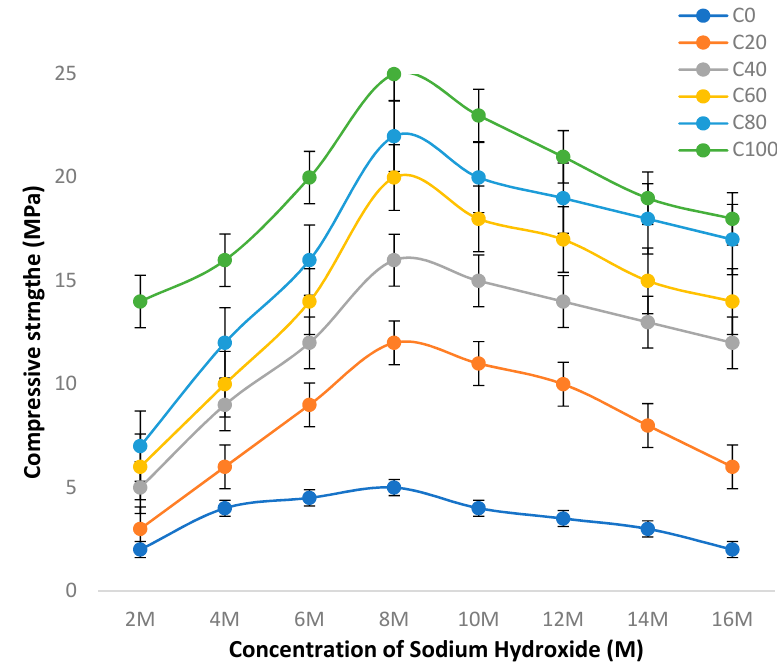
Figure 4. Effect of NaOH on the compressive strength.